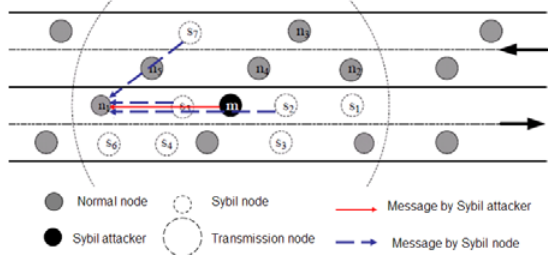
Fig.1. Sybil attack in a